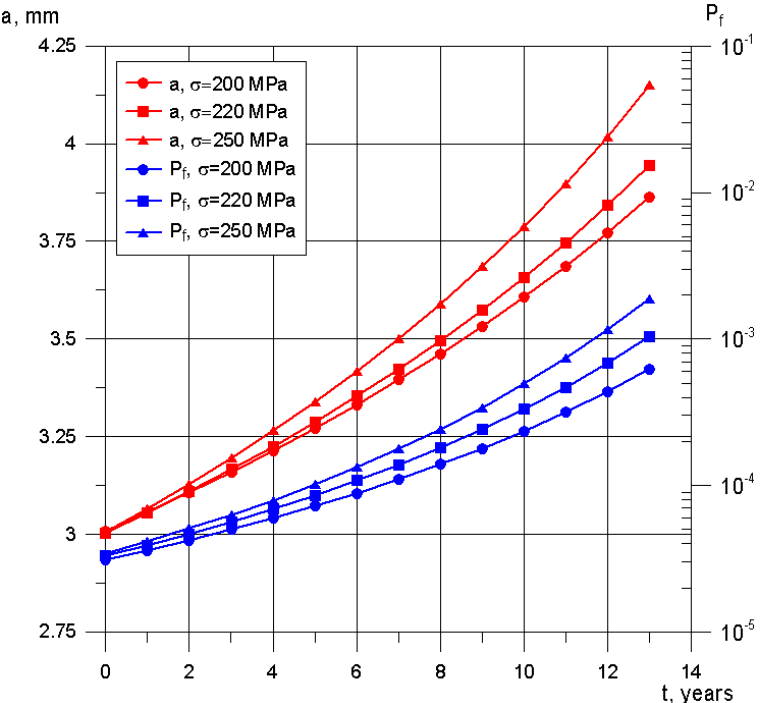
Figure 5. Crack propagation and turbine rotor failure probability over 13 years of operation.